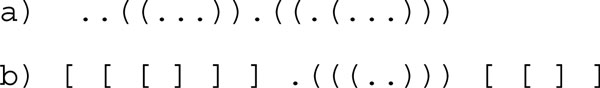
Bracket notation. Bracket notation for the structures in Figure 1.